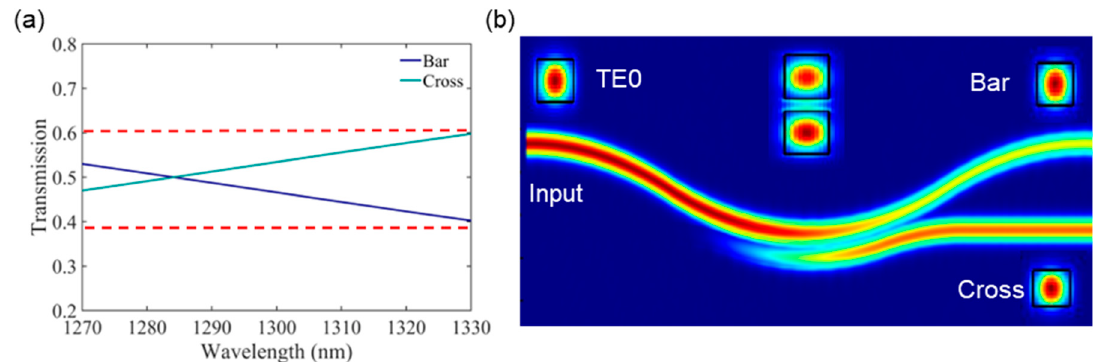
Figure 2. ( a ) Simulated transmission curve of the initial structure without silicon columns introduced. ( b ) Simulated light fi eld pro fi le of the initial structure with TE0 mode excited.